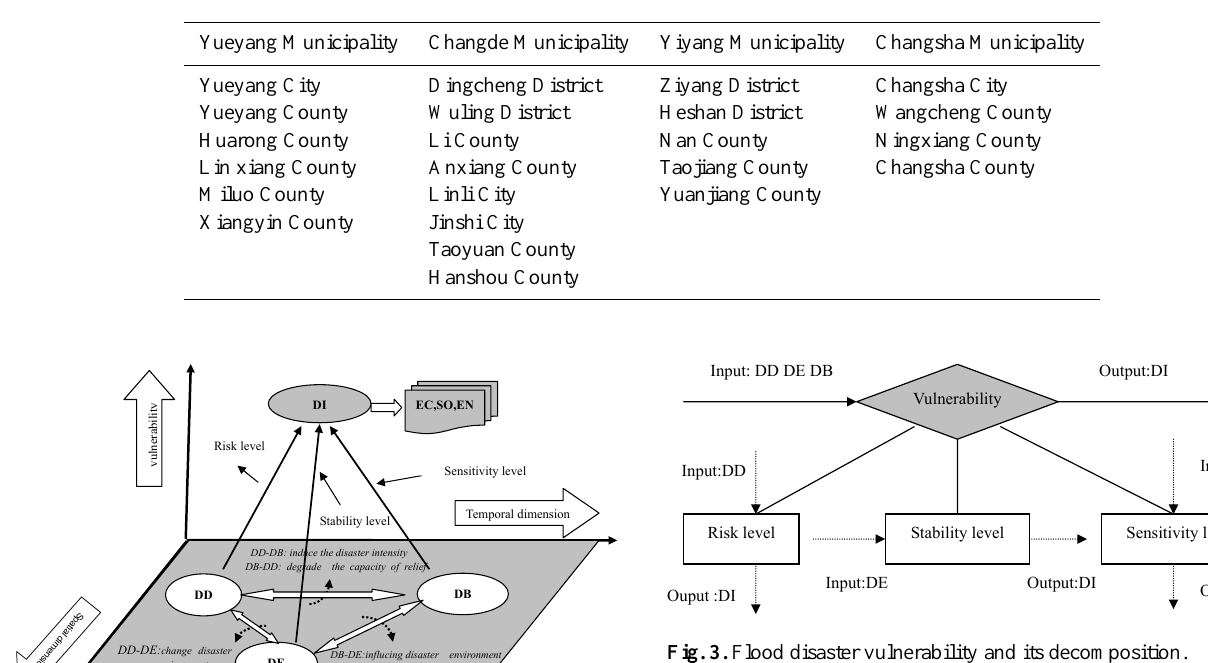
Table 1. Administrative units of the Dongting Lake region.